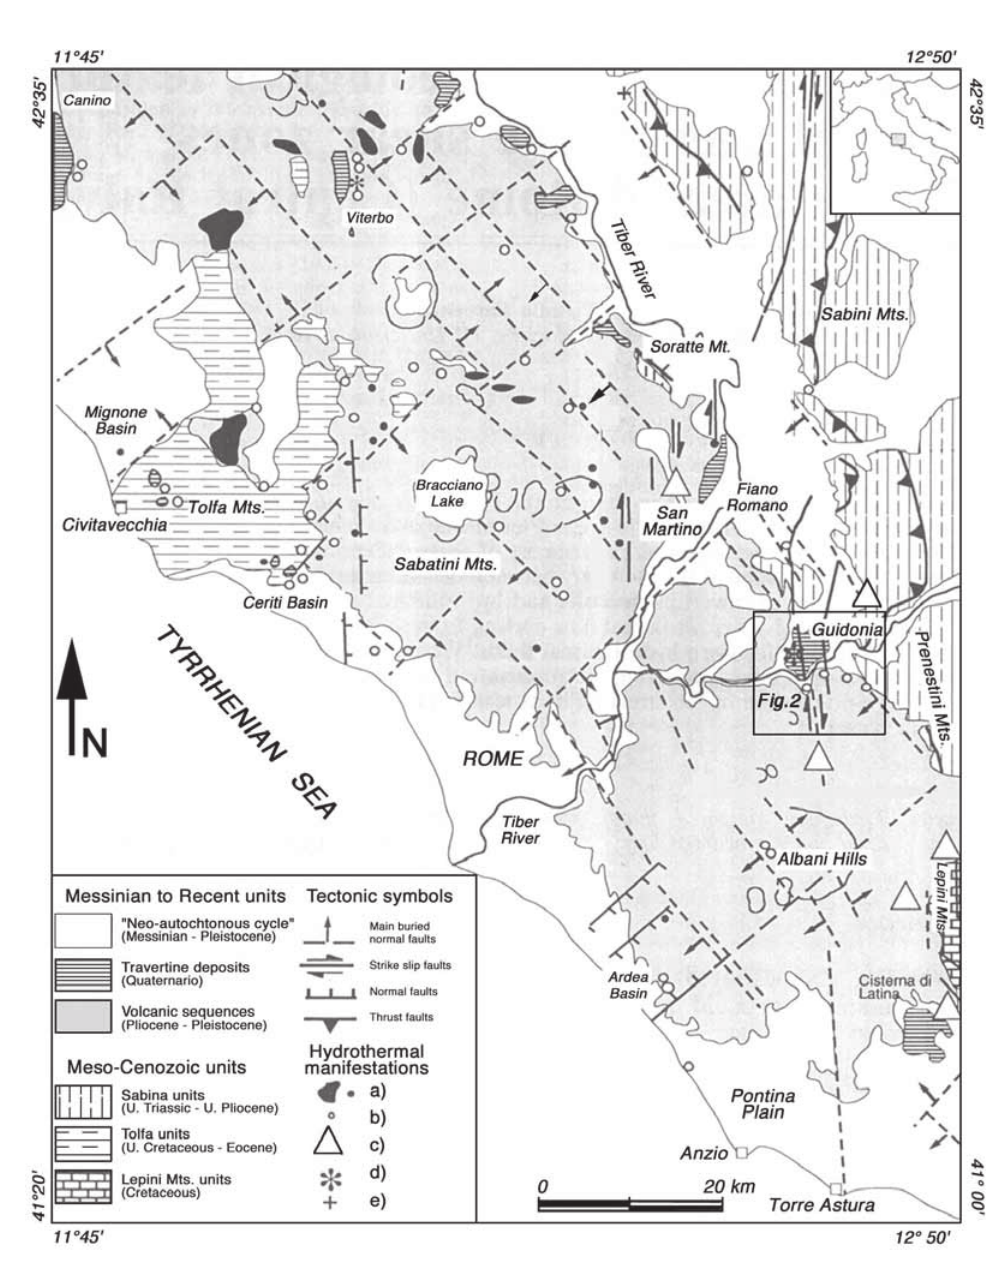
Fig. 1. Schematic map of the Latium Tyrrhenian margin and their correlation with the Acque Albule travertine basin. There are also many hydrothermal appearances: a) alunite and kaolin mineralization; b) leakages associated with small springs (with a temperature often up to 20 ° C); c) groups of sinkholes; d) springs affected by hydrothermal activity ( T > 20 ° C); e) mineralised springs (TDS > 0.75 g/l; T < 20 ° C). From Faccenna (1994)